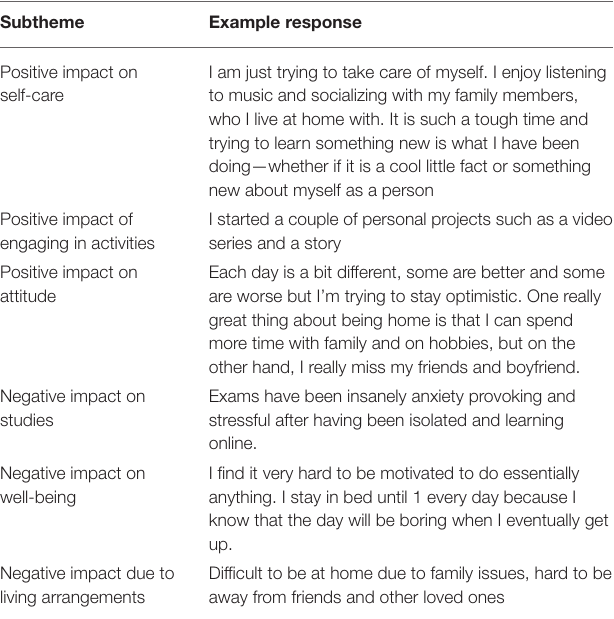
TABLE 4 | Example responses to the open-ended question falling into each of the three positive and three negative subthemes.